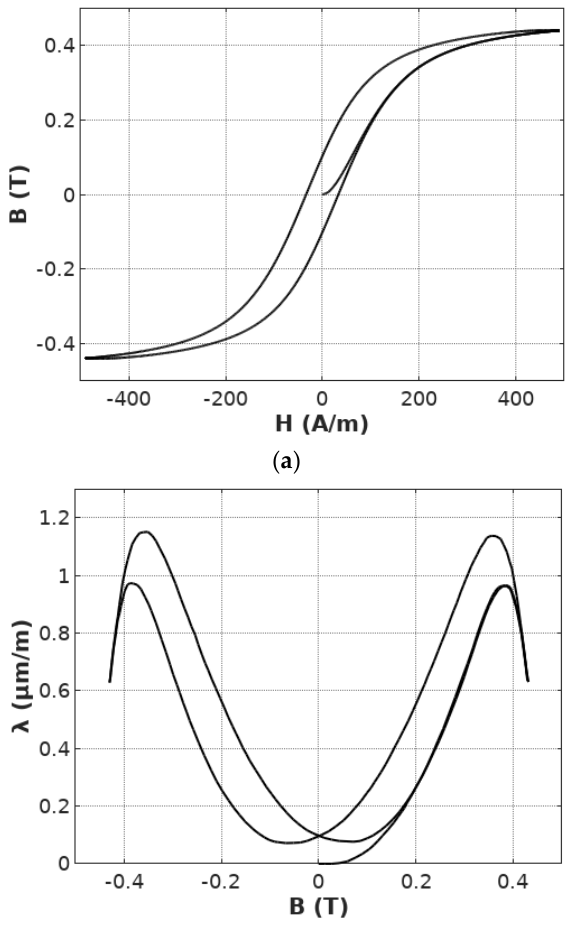
Figure 3. Results of measurements of hysteresis loops of Mn 0.70 Zn0. 24 Fe 2.06 O 4 ferrite for power applications: ( a ) B ( H ) magnetic hysteresis loop; ( b ) λ ( B ) magnetostrictive hysteresis loop (both magnetostrictive hysteresis and the lift-off phenomenon clearly visible).